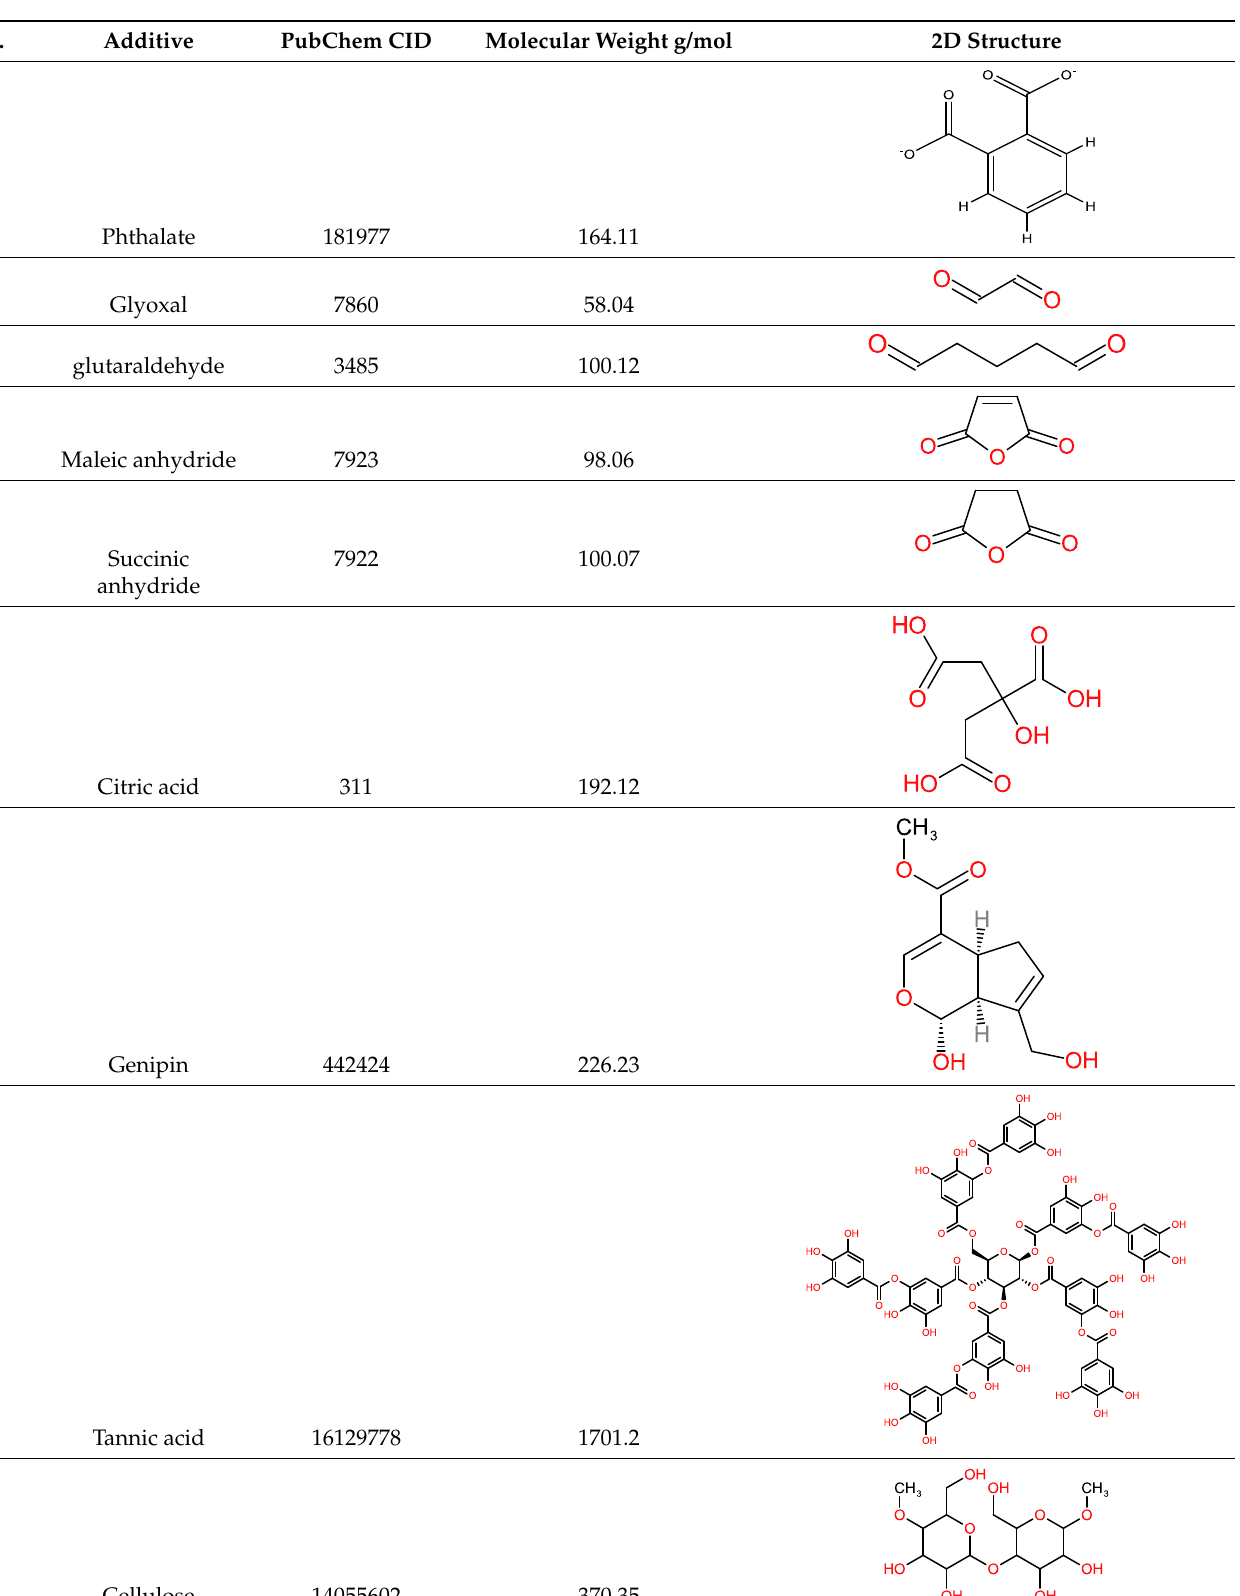
( B ) Figure 1. crystal structure of canola procruciferin, 11S globulin ( A ) and soy glycinin A3B4 subunit ( B ). Table 1. The chemical structure and molecular weight of the compounds evaluated. No